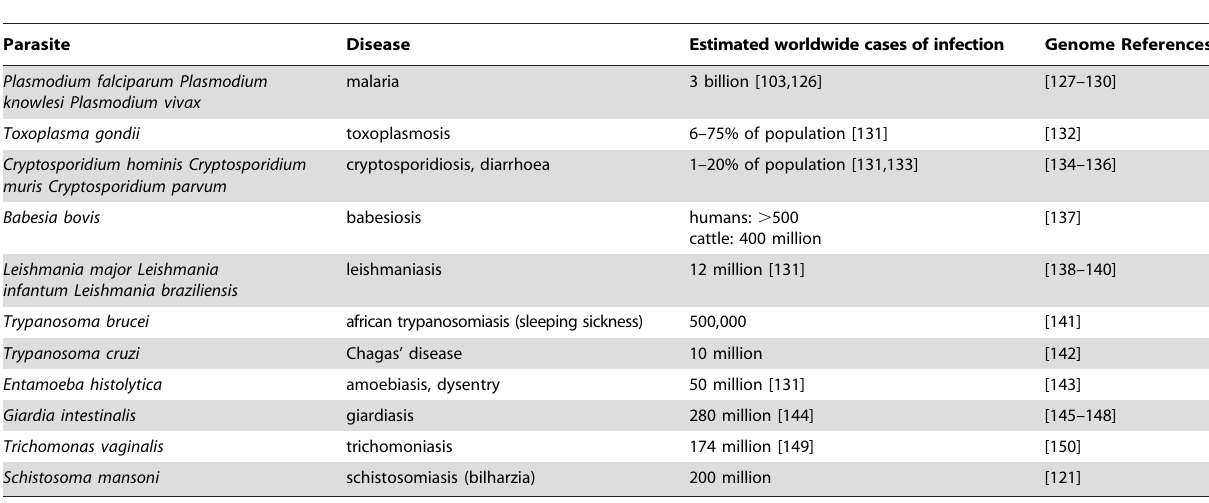
Table 1. Pathogenic parasites with completed whole-genome sequences, their associated diseases and worldwide disease